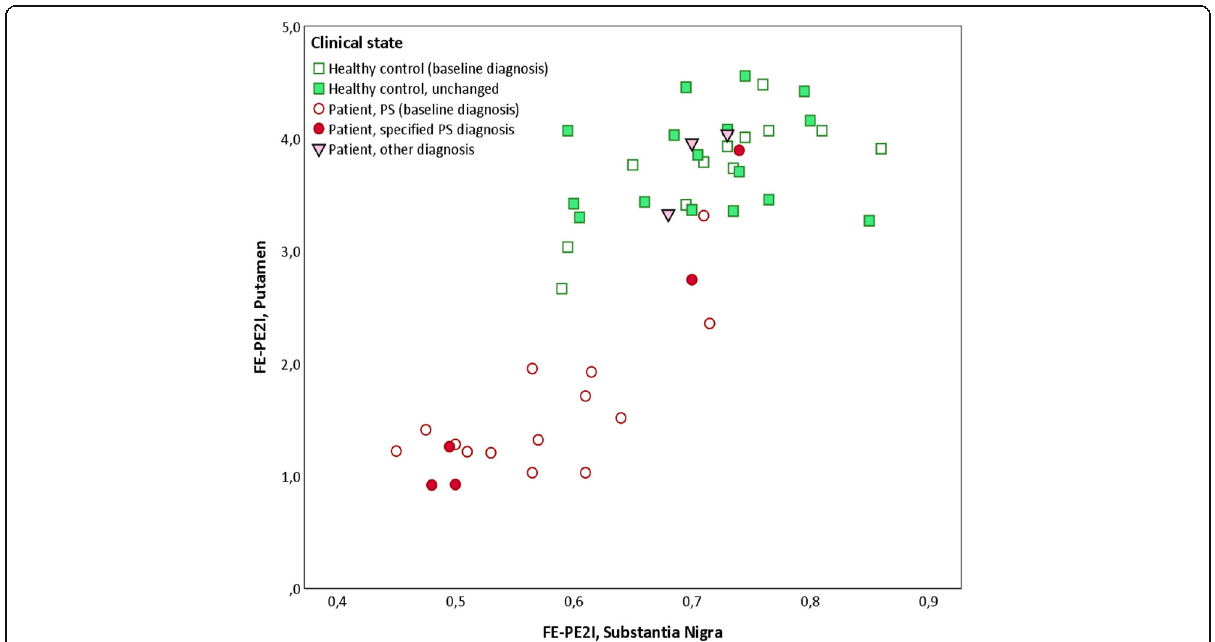
Fig. 6 DAT availability in the putamen versus the substantia nigra. The relationship between the mean DAT availability in the putamen (left and right side averaged) and the SN (left and right side averaged), measured with FE-PE2I in HC and patients. Empty squares indicate HC that are not yet followed up. Filled squares indicate HC that are still healthy at follow-up after 2 years. Filled circles indicate patients that fulfilled clinical criteria for PS at inclusion and fulfilled clinical criteria for a specific parkinsonian syndrome at follow-up after 2 years. Empty circles indicate patients that fulfilled clinical criteria for PS at inclusion, not yet clinically followed up. Filled triangles indicate patients that fulfilled clinical criteria for PS at inclusion, but did not fulfil clinical criteria for a specific parkinsonian syndrome at follow-up after 2 years. HC, healthy controls; PS, parkinsonian syndrome; SN, substantia nigra; BP ND , binding potential relative to non-displaceable binding; FE-PE2I, [ 18 F]FE-PE2I PET; FP-CIT, [ 123 I]FP-CIT